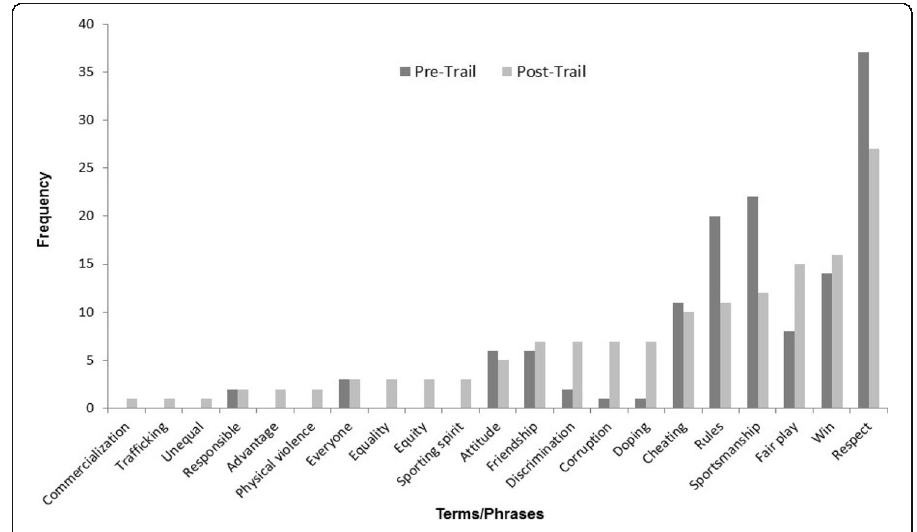
Fig. 5 Comparison of UG students ’ ( n = 111) pre-/post-TIE-SR reflections (semester 1, 2015 and semester 1, 2016). Pre-trail question: What is your view on sports ethics? Post-trail question: From the learning trail, what have you learned about sports ethics? Note: For the purpose of clarity, some words/phrases have been shortened for presentation in Fig. 5 as follows: Excessive commercialization ➔ Commercialization, Unequal opportunities ➔ Unequal, Everyone else is doing it/Everyone else/Everybody else/Everyone/ Everybody ➔ Everyone, Winning is the only thing/Winning/Win ➔